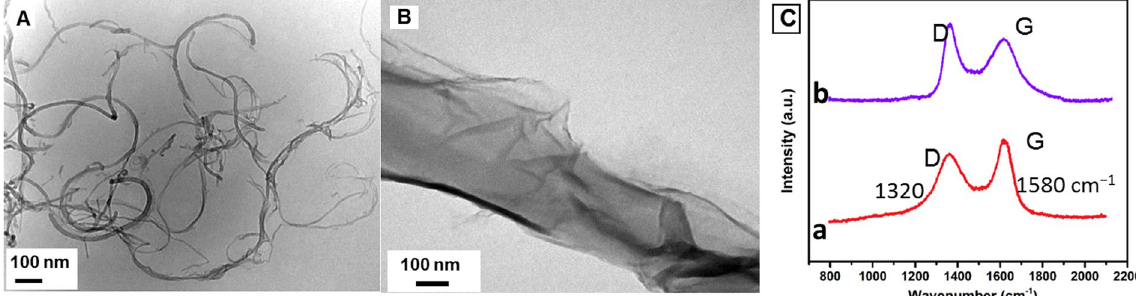
Figure 1. TEM images of MWCNTs ( A ) and MWCNTs@rGONRs ( B ). ( C ) Raman spectra of MWCNTs (a) and MWCNTs@rGONRs